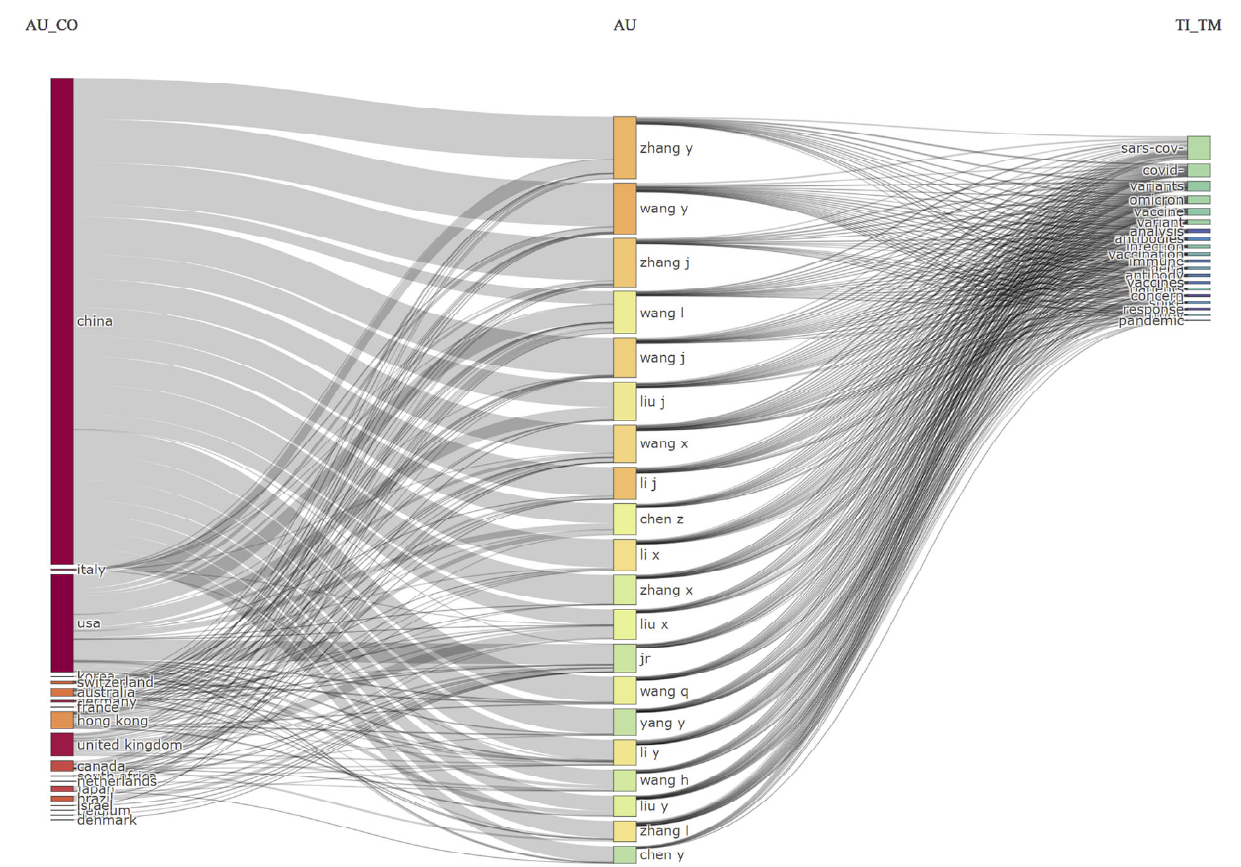
Figure 11. Relationship found in Omicron-based research between countries, authors, and keywords.